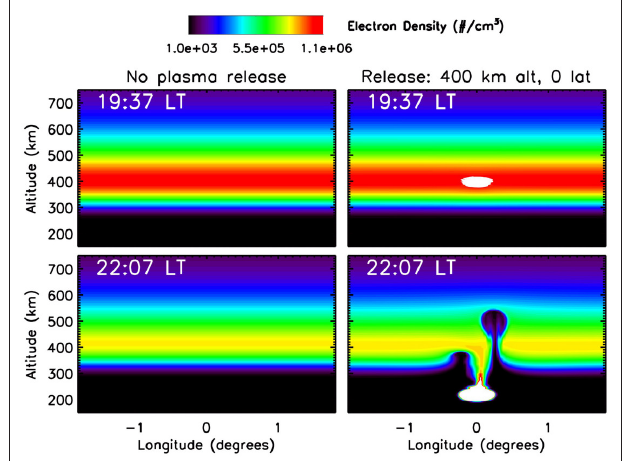
FIGURE 3 | Electron density (log 10 cm − 3 ) as a function of latitude and altitude at four times during the simulation. At 19:30 LT 5.0 × 10 7 cm − 3 Al + ions are released at 400 km altitude, 0 ◦ latitude. The plasma spreads along the field line (as shown in the Top right and Bottom left ), then the structure begins to drift downwards.